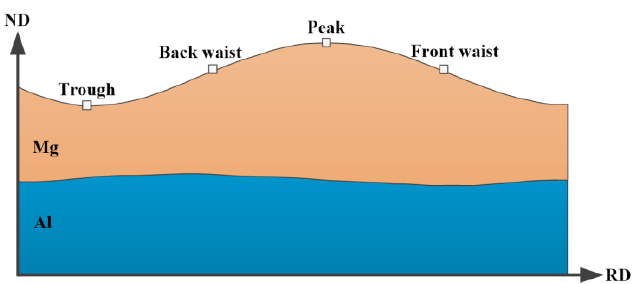
Figure 3. Four positions of the corrugated Mg/Al clad sheet.